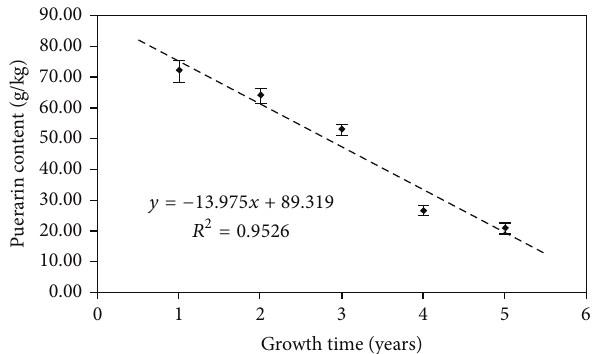
Figure 3: Changes of puerarin content of kudzu root during growth. The data were reported as means ± standard